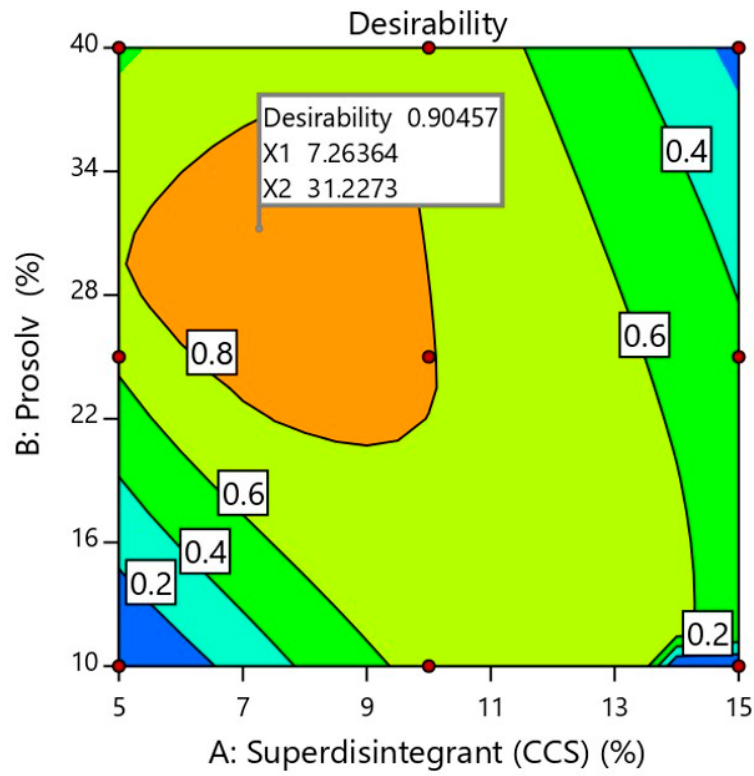
Figure 4. Optimization plot showing the influence of independent formulation variables on overall desirability. X1 and X2 represents the concentration of superdisintegrant and Prosolv ® in the optimized SUL-FDTs formulation.